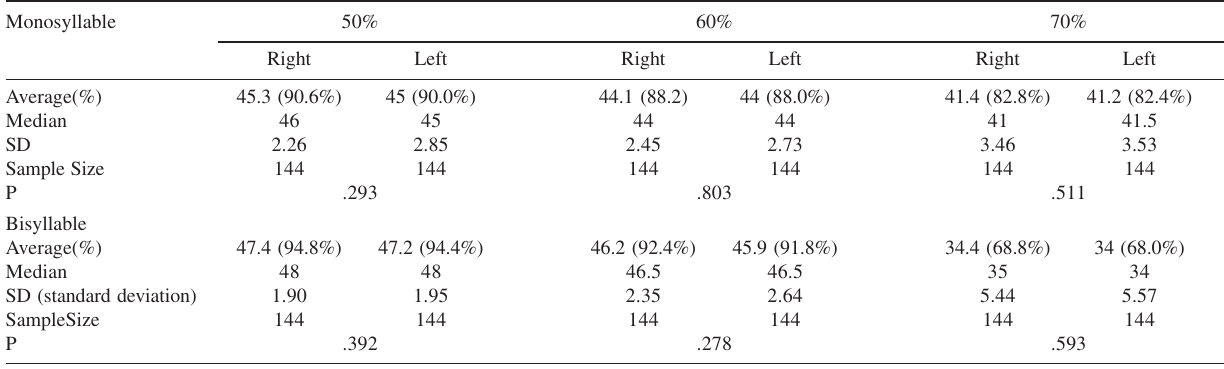
Table 1 - Comparison by ANOVA of the results obtained with the right and left ears for the monosyllable and bisyllable tests at the 3 compression